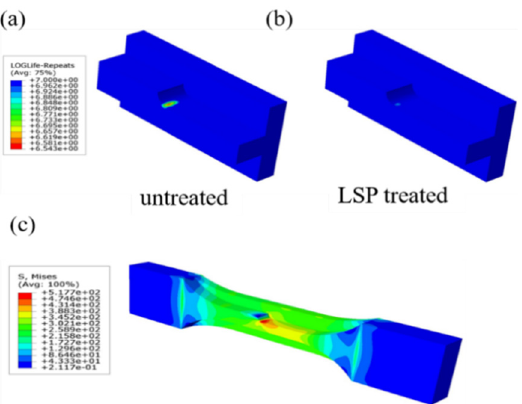
Figure 9. ( a , b ) Fatigue simulation of untreated and LSP-treated frame beams. ( c ) Static analysis results of frame beam structure simulation.